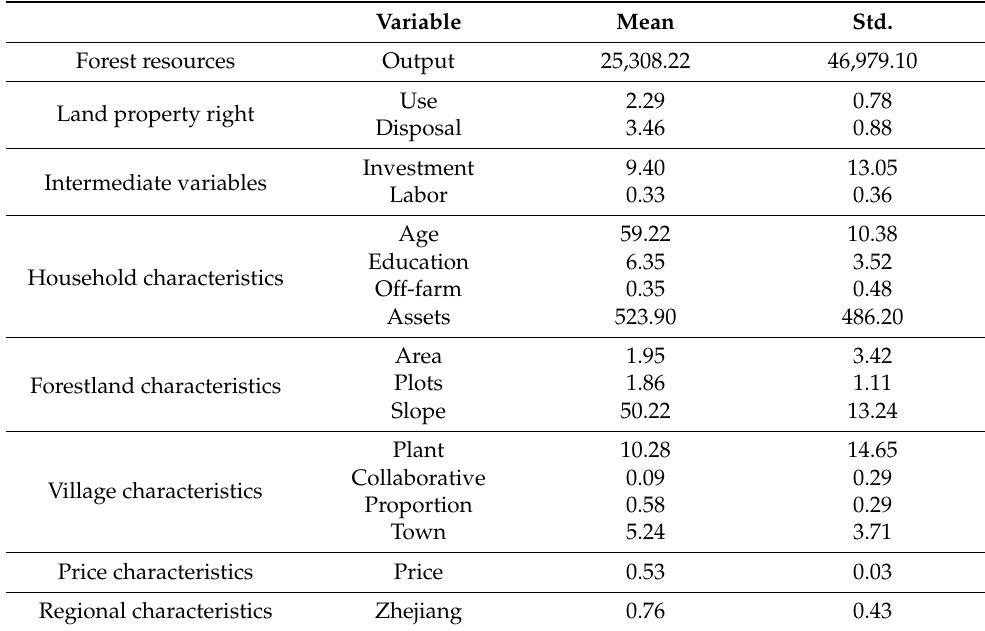
Table 2. Descriptive